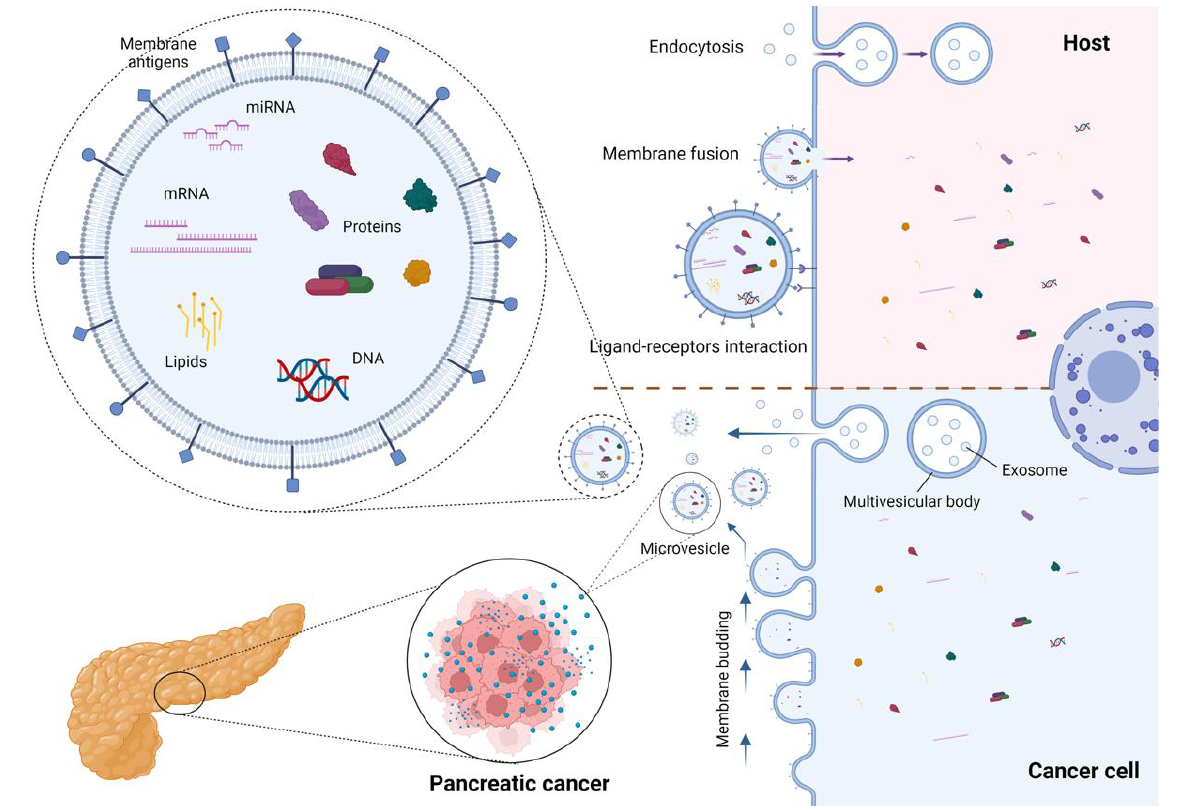
Figure 1. Biogenesis, structure, and cell interaction of extracellular vesicles. Created with BioRen- der.com.